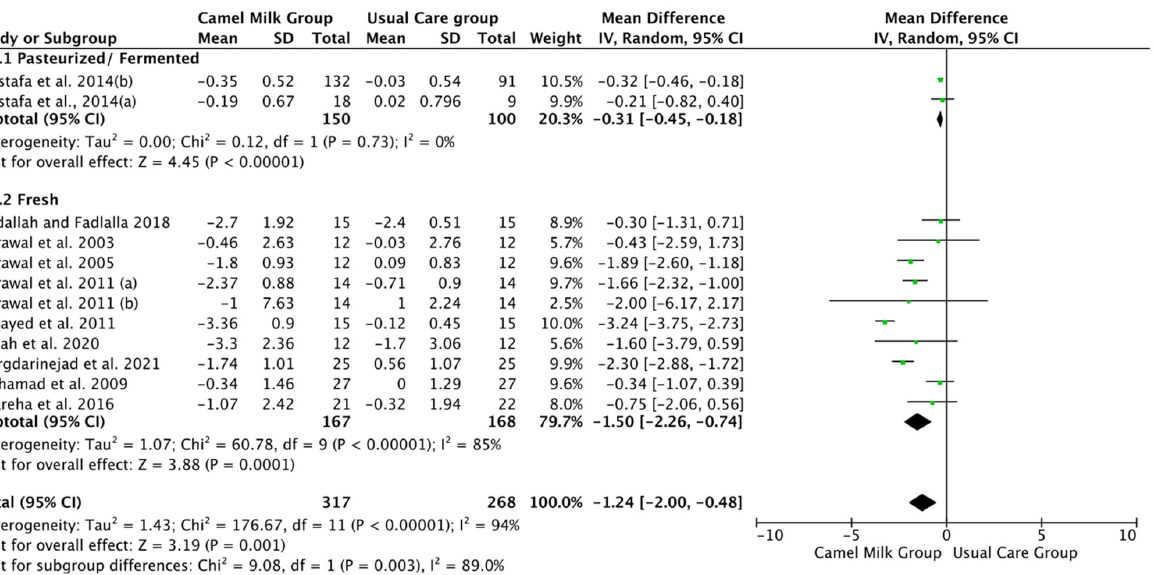
Figure 13. Forest plot for the effect of CM intake on HbA1c levels based on the type of diabetes. Note: Mostafa and Al ‐ Musa, 2014 (a) for T1DM and (b) for T2DM.